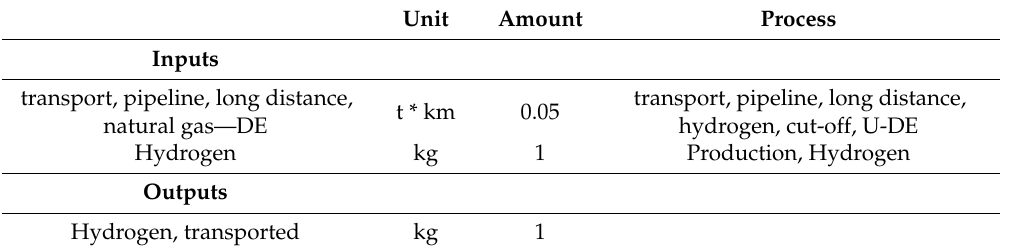
Table A11. Transport Hydrogen.